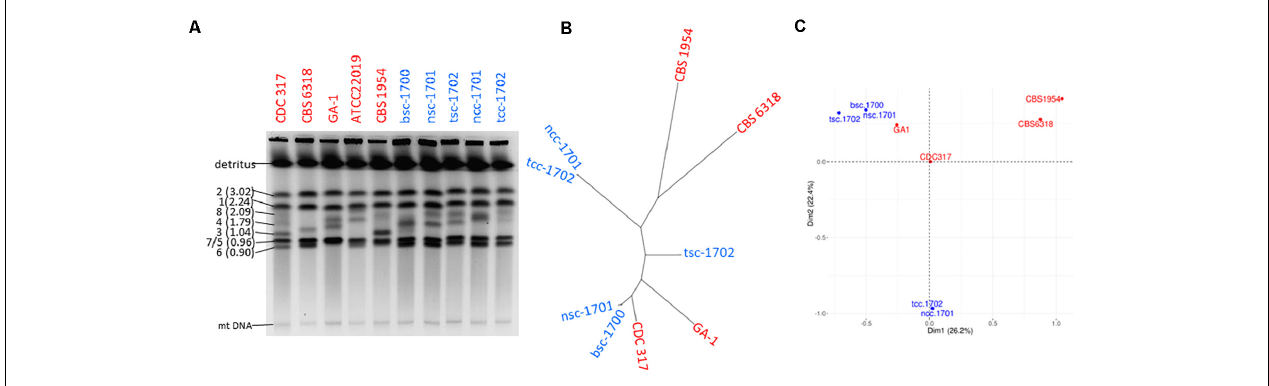
FIGURE 3 | Strain typing and genome sequencing. (A) Pulse-field gel electrophoresis suggests the five isolates (blue) are not clonal. (B) Distance-based and (C) MCA cluster analysis of the SNPome placing the 5 patient isolates into the context of other genome-sequenced strains (red), relative to CDC-317. Both indicate the simultaneous presence of at least three independent clonal groups in the